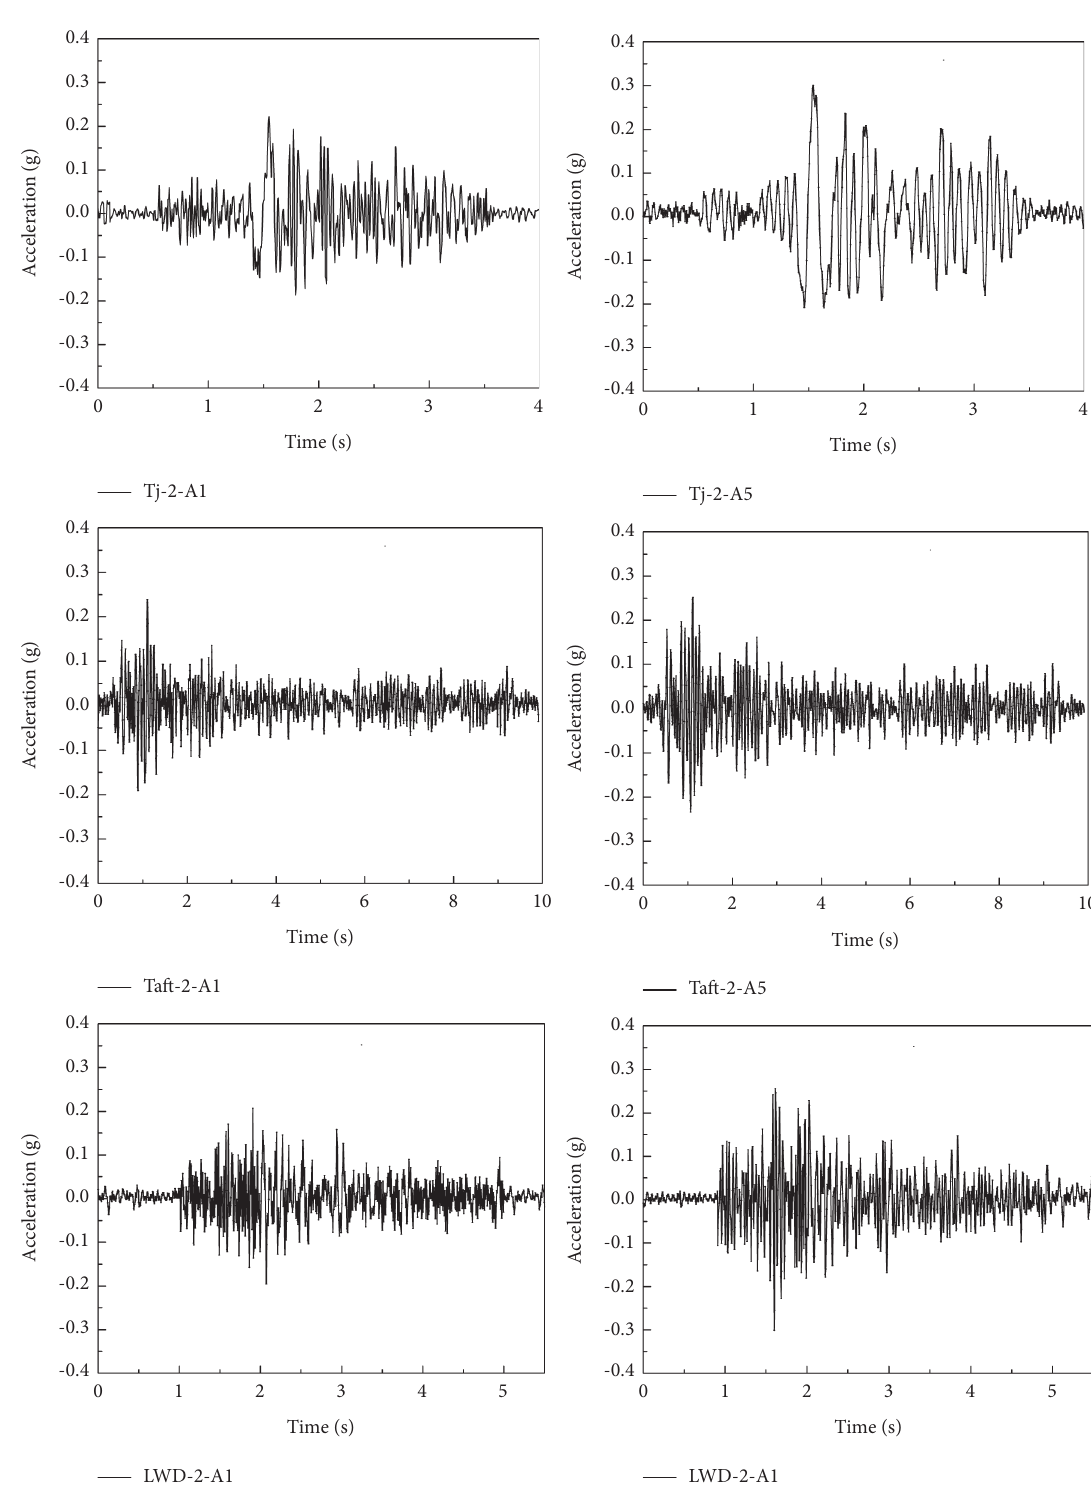
Figure 6: Acceleration time history of model